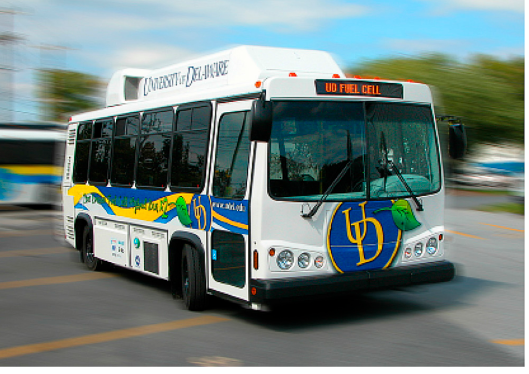
Figure 1. The University of Delaware’s 22-foot, 22-seat transit bus equipped with a fuel cell/battery series-hybrid powertrain, manufactured by EBus, Inc. of Downey, CA,